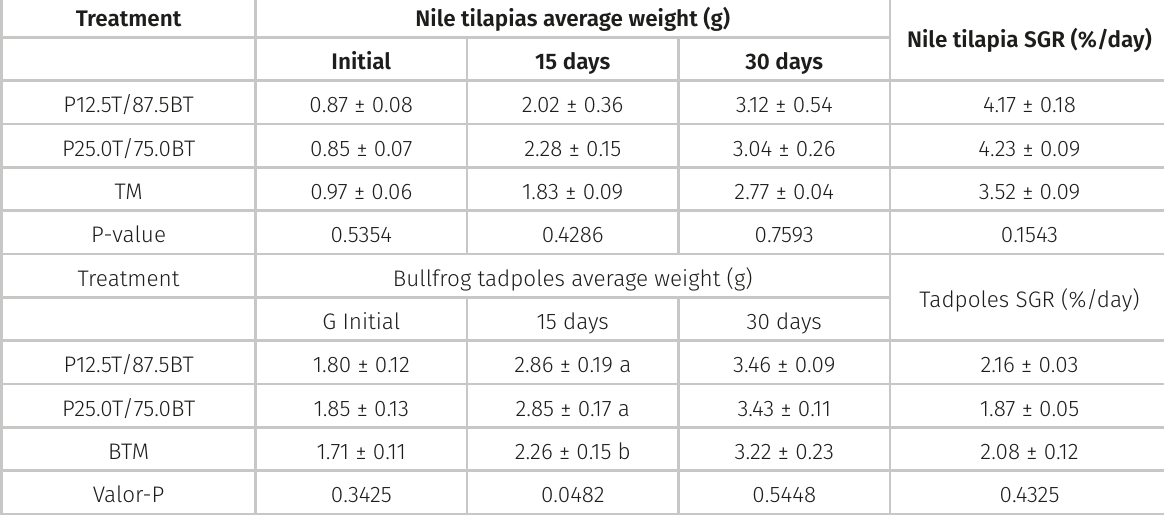
Table IV. Average weight (g) and specific growth rate (%/day) of bullfrog tadpoles (BT) and Nile tilapias (T) during the experimental period in the polyculture (P), tilapia monoculture (TM) and a bullfrog tadpole monoculture (BTM) breeding in the experiment 2.